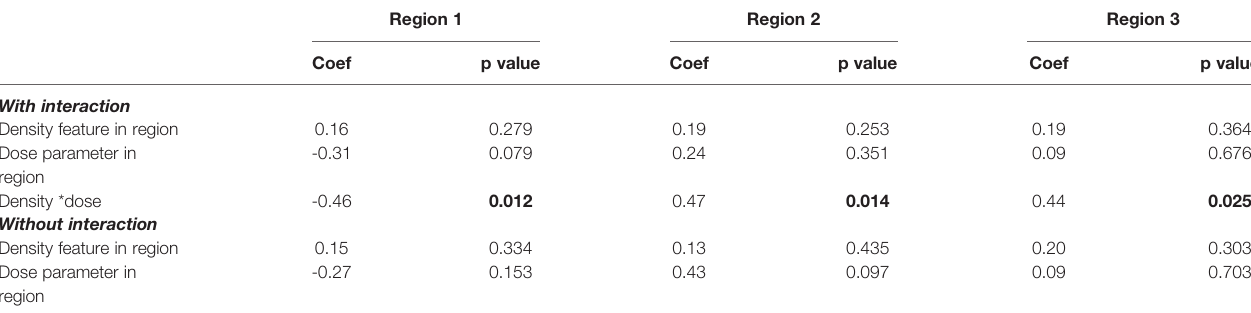
FIGURE 5 | Left: Cox per radius signi fi cance maps of interaction between density versus dose parameters at distance from the GTV [note the difference in x- and y- axis labels for (A) , (B) , and (C) ]. p-value represents the result of a likelihood-ratio test of improvement in model performance due to inclusion of the interaction between dose and density at each location. All signi fi cant points are shown with a white circle, and the region extracted for assessment in bootstrap is highlighted in light pink. After removal of regions that are too small, have near zero variance, have unstable coef fi cients, or do not improve model performance, only three remained (dark pink). Right: volumes de fi ned by the selected regions on an example TABLE 3 | Coef fi cients (coef) and p-values for the density features and dose parameters extracted from the multivariable model for each region.